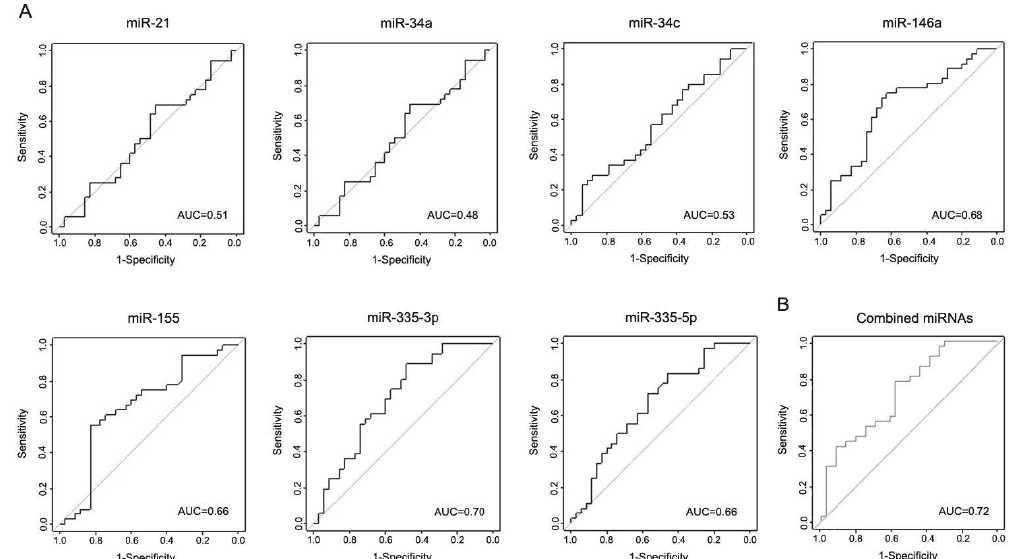
Figure 5. ( A ) ROC curves of combined miRNAs in discovery and validation cohorts, discriminating between controls and iPD patients. ( B ) ROC curves of models created from binary logistic regression to improve discrimination between the two groups. AUC values are indicated in each plot.